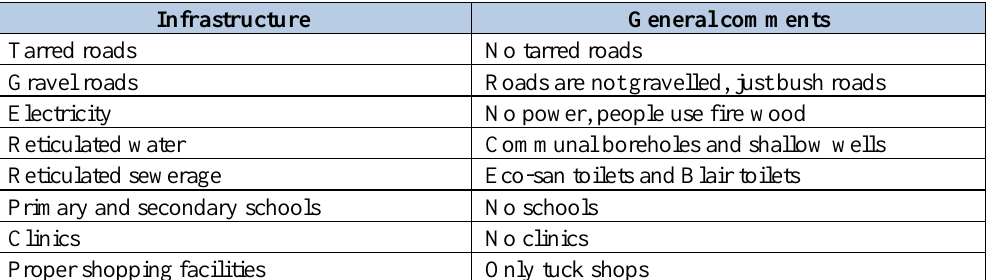
Table 2. Type of Infrastructure in Cowdrey Park and the General Public Comments (developed by the